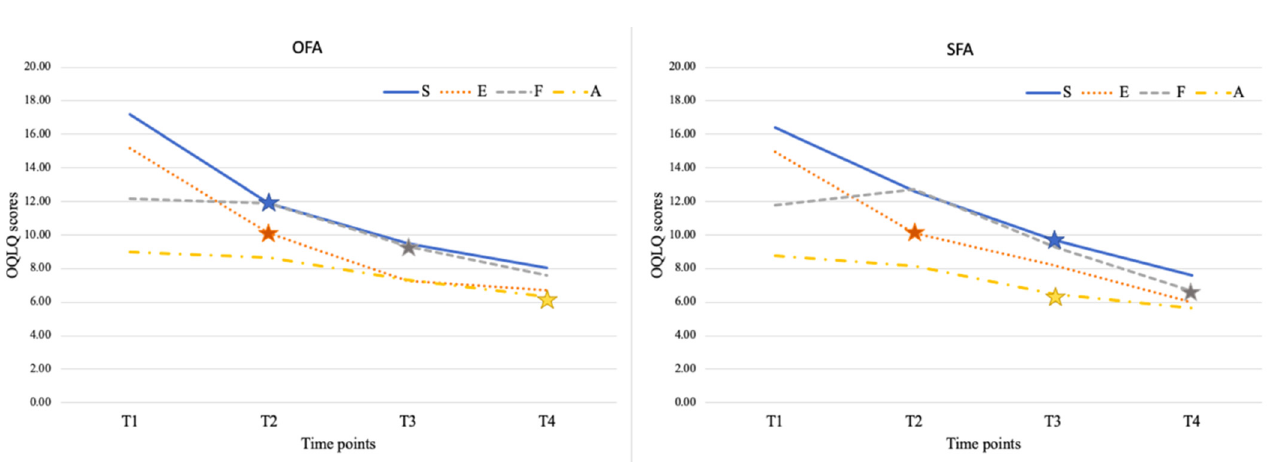
Figure 1. The change in domain scores at each time point